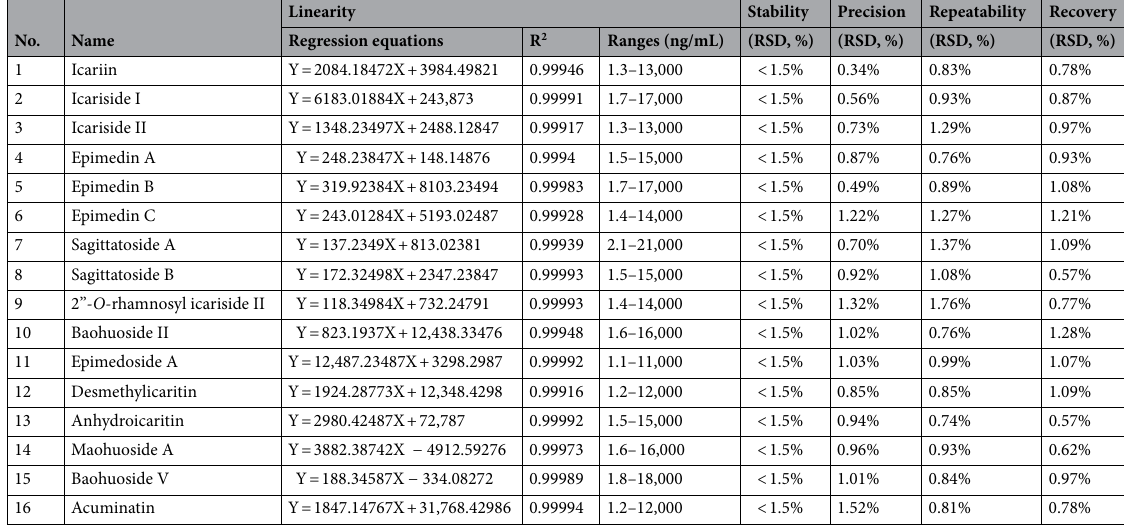
Table 2. Method validation results including linearity, stability, precision repeatability and